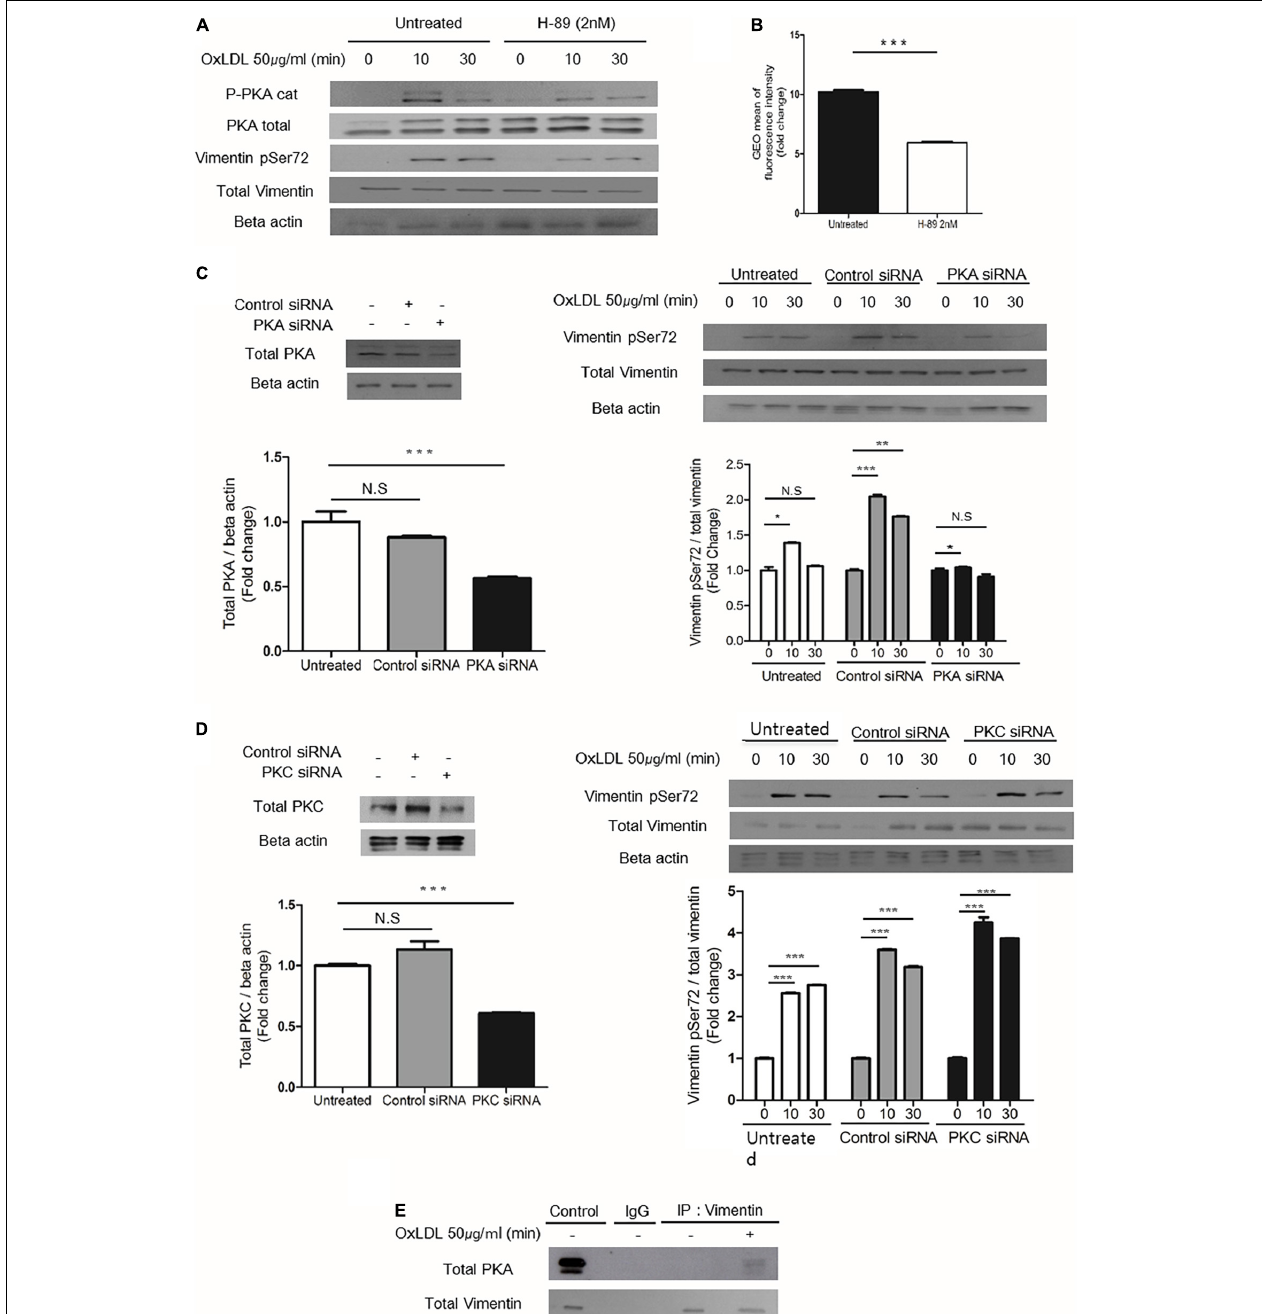
FIGURE 5 | PKA mediates oxLDL-induced vimentin (Ser72) phosphorylation. (A) Wild type murine peritoneal macrophages pretreated with H-89(2 nM), a specific PKA inhibitor were incubated with oxLDL (50 µ g/ml) for indicated times. The lysates were analyzed by immunoblot for phosphorylated vimentin (Ser72) and total vimentin. Beta actin was used for internal control. (B) Flow cytometry data. BMDMs were pretreated with or without H-89 (2 nM) and then exposed to DiI- oxLDL (50 µ g/ml) for 5 min. The fluorescence intensities of these cells were measured. (C) Left, Western blot analysis for PKA was performed using cell lysates of wild type murine BMDM transfected with control siRNA or siRNA against PKA. Cells were lysed 24 h after the siRNA treatment and analyzed by immunoblot for PKA. Right: Wild type murine BMDMs were transfected with control siRNA or siRNA against PKA and incubated with oxLDL (50 µ g/ml) for indicated times and analyzed by western blot. (D) Left: Western blot analysis for PKC was performed using cell lysates of wild type murine BMDM transfected with control siRNA or siRNA against PKC. Cells were lysed 24 h after the siRNA treatment and analyzed by immunoblotting to confirm the suppression of PKC expression. Right: Wild type murine BMDMs were transfected with control siRNA or siRNA against PKC and incubated with oxLDL (50 µ g/ml) for indicated times and analyzed by western blot. (E) Vim + / + murine peritoneal macrophages were treated with or without oxLDL (50 µ g/ml) for 10 min and immunoprecipitated with anti-vimentin antibody. The precipitants were analyzed by western blot for PKA. * p < 0.05, ** p < 0.01, *** p < 0.001.